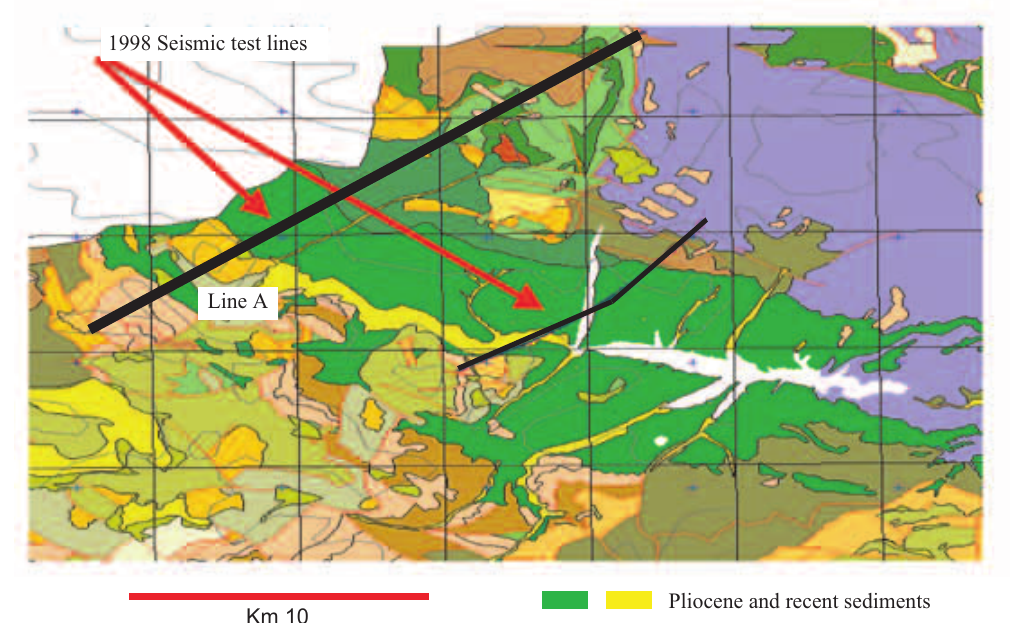
Fig. 3. Location of the 1998 2D seismic test